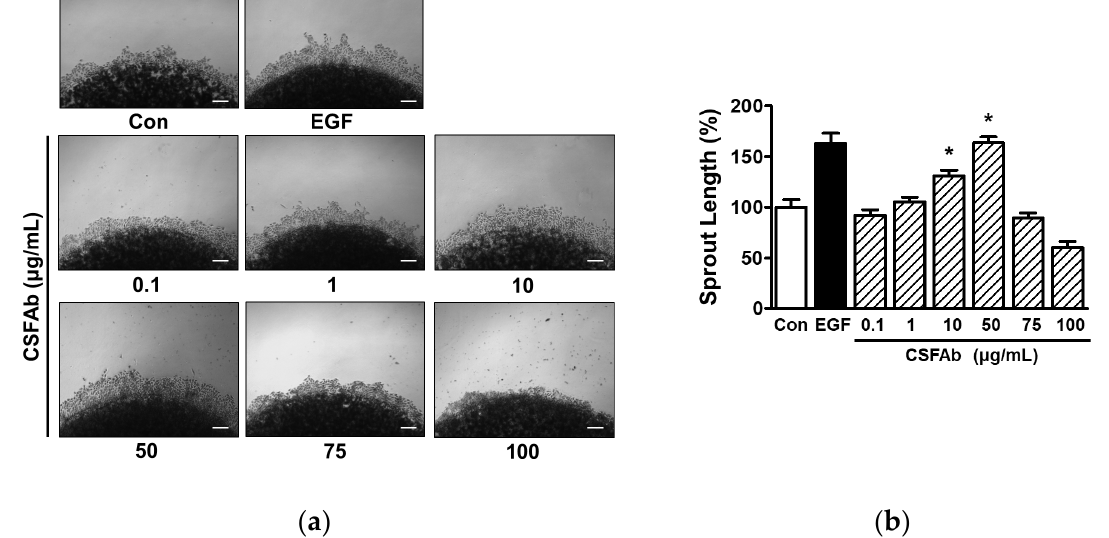
Figure 2. Effect of Caragana sinica flower absolute on HaCaT cell sprout formation. ( a ) Representative images of experimental results. HaCaT cells were mixed with collagen, spotted in the wells of a 24-well plate, and treated with or without Caragana sinica flower absolute (CSFAb; 0.1–100 μg/mL) for 48 h. Spots and cell sprouts were incubated with Diff-Quick solution and images were taken using a microscope. Recombinant human epidermal growth factor (EGF: 50 μg/mL): positive control. Scale bar = 50 μm. ( b ) Statistical graph of results obtained from panel ( a ). Results are expressed as mean percentages ± SEMs ( n = 3) of untreated controls (Con). * p < 0.05 vs. untreated controls.